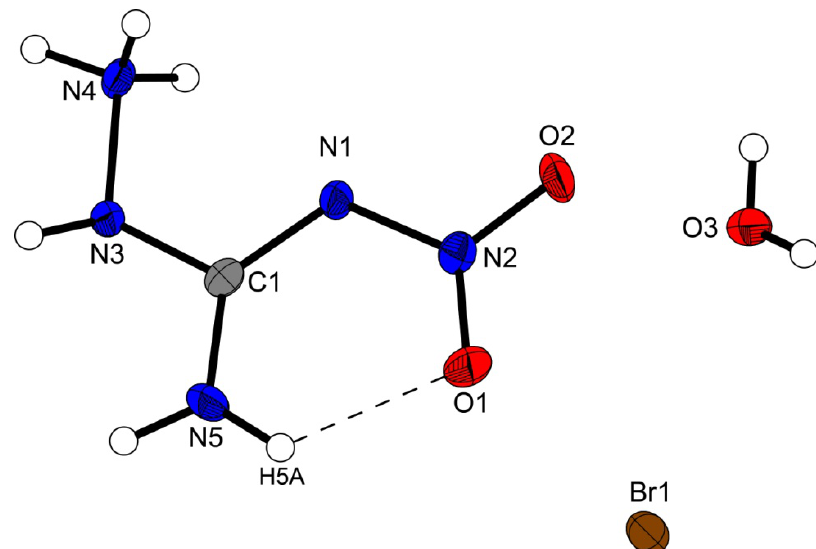
Figure 5. Coordination sphere of one bromide anion in 3 . Symmetry codes: (i) − 1 + x , 0.5 − y , − 0.5 + z ; (ii) − 1 + x , y , z ; (iii) x , 0.5 − y , 0.5 + z ; (iv) 1 − x , 0.5 + y , 1.5 − z ;